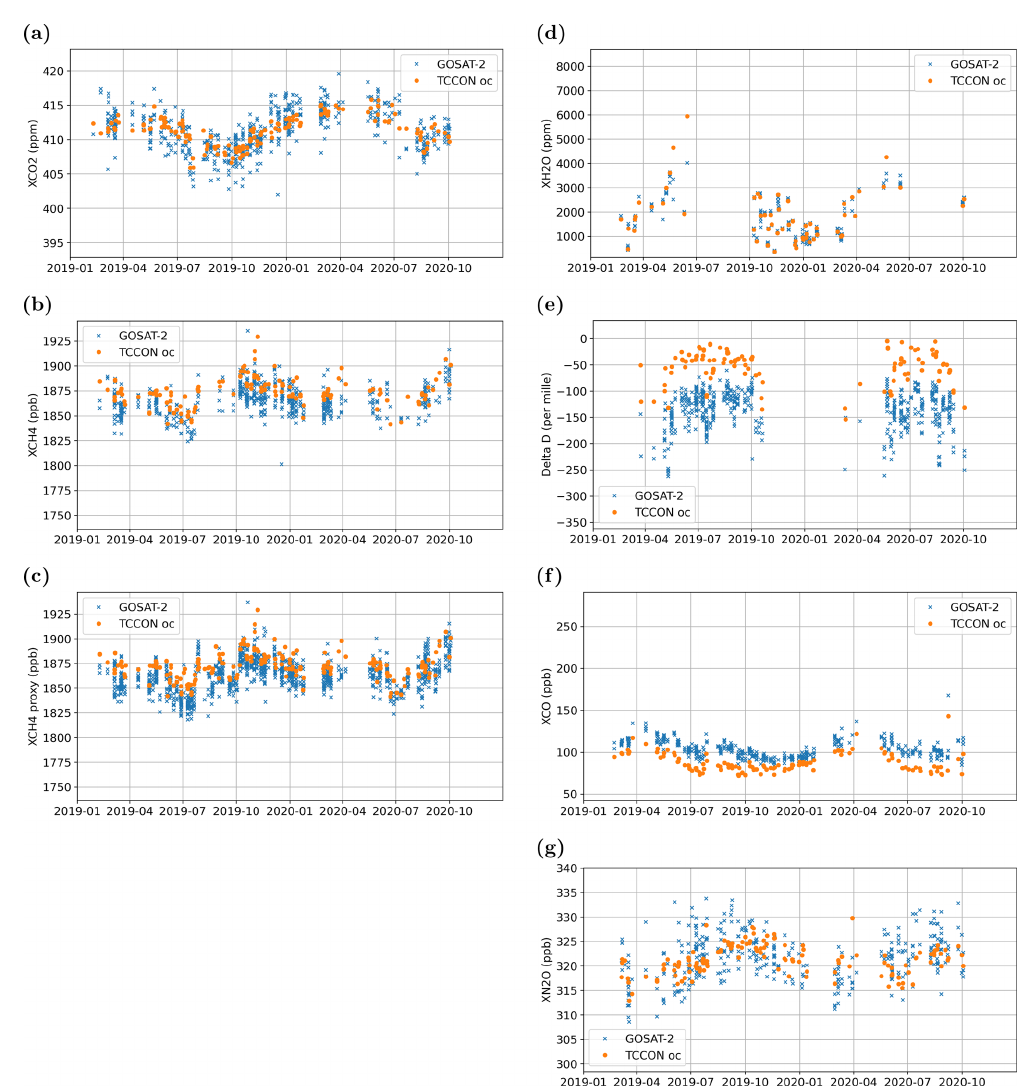
Figure 16. Example time series of TCCON and GOSAT-2 FOCAL data at Lamont (station code oc). (a) XCO 2 ; (b) XCH 4 full-physics product; (c) XCH 4 proxy product; (d) XH 2 O; (e) δ D; (f) XCO; (g) XN 2